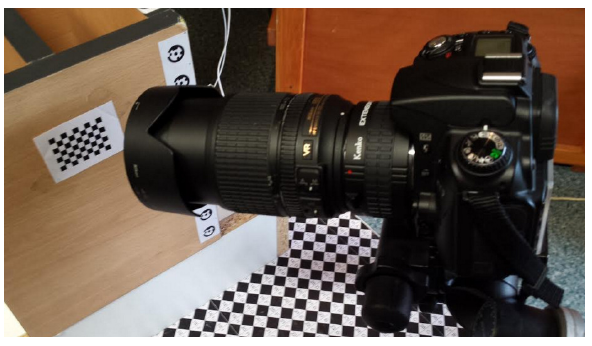
Figure 1. Camera with extension tube at the calibration field Twelve photographs were taken from each side of the amber figurine. They were taken from different positions, evenly distributed on the same distance from